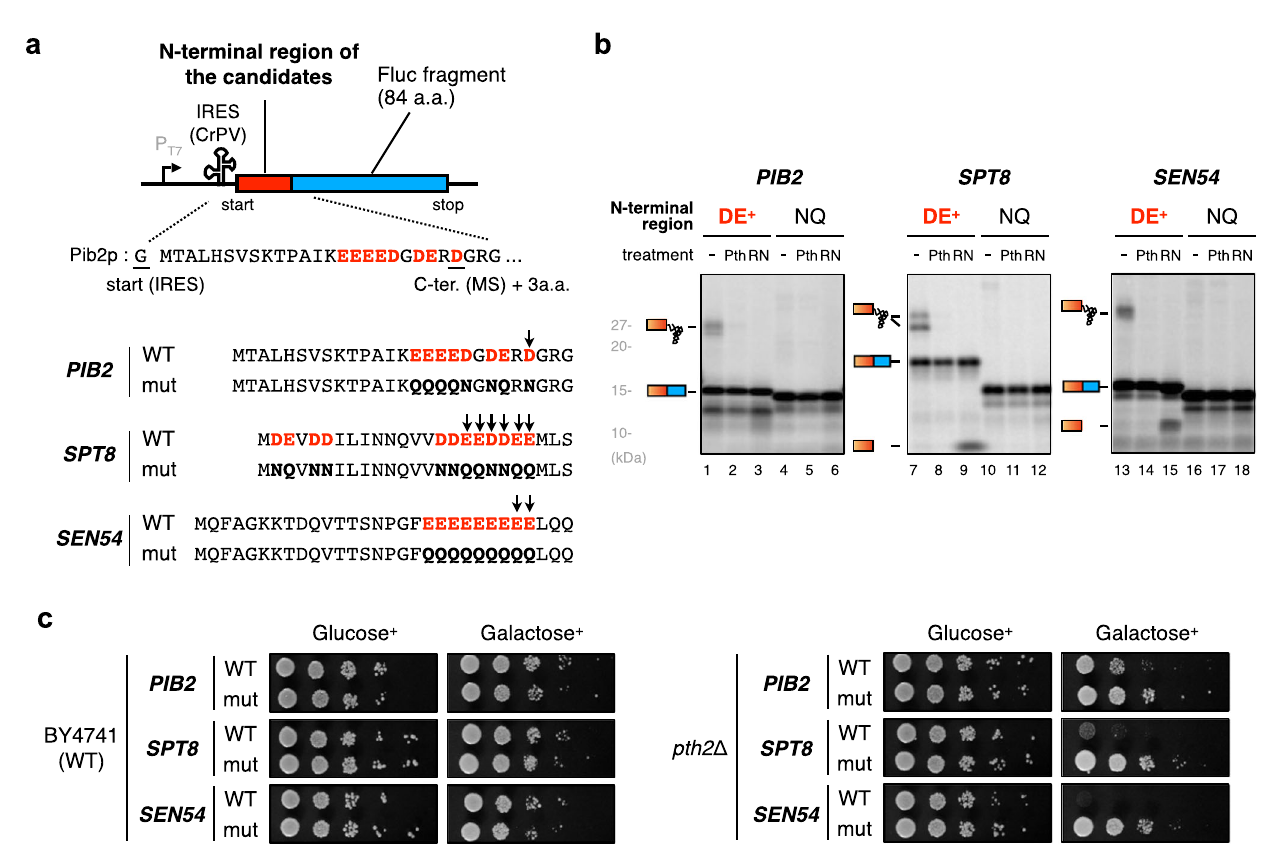
Fig. 6 | IRD during the translation of LC-MS/MS-identi fi ed endogenous genes. a Schematic representation of the sequences from endogenous genes for the HsPURE in vitrotranslation assayand the spot assay. N-terminal amino acid motifs detectedbyMSin pth2 Δ cells(with3a.a.extension)weresubstitutedforGFP n − 10X of the constructs in Fig. 1a and Fig. 1d. b IRD during the translation of endogenous